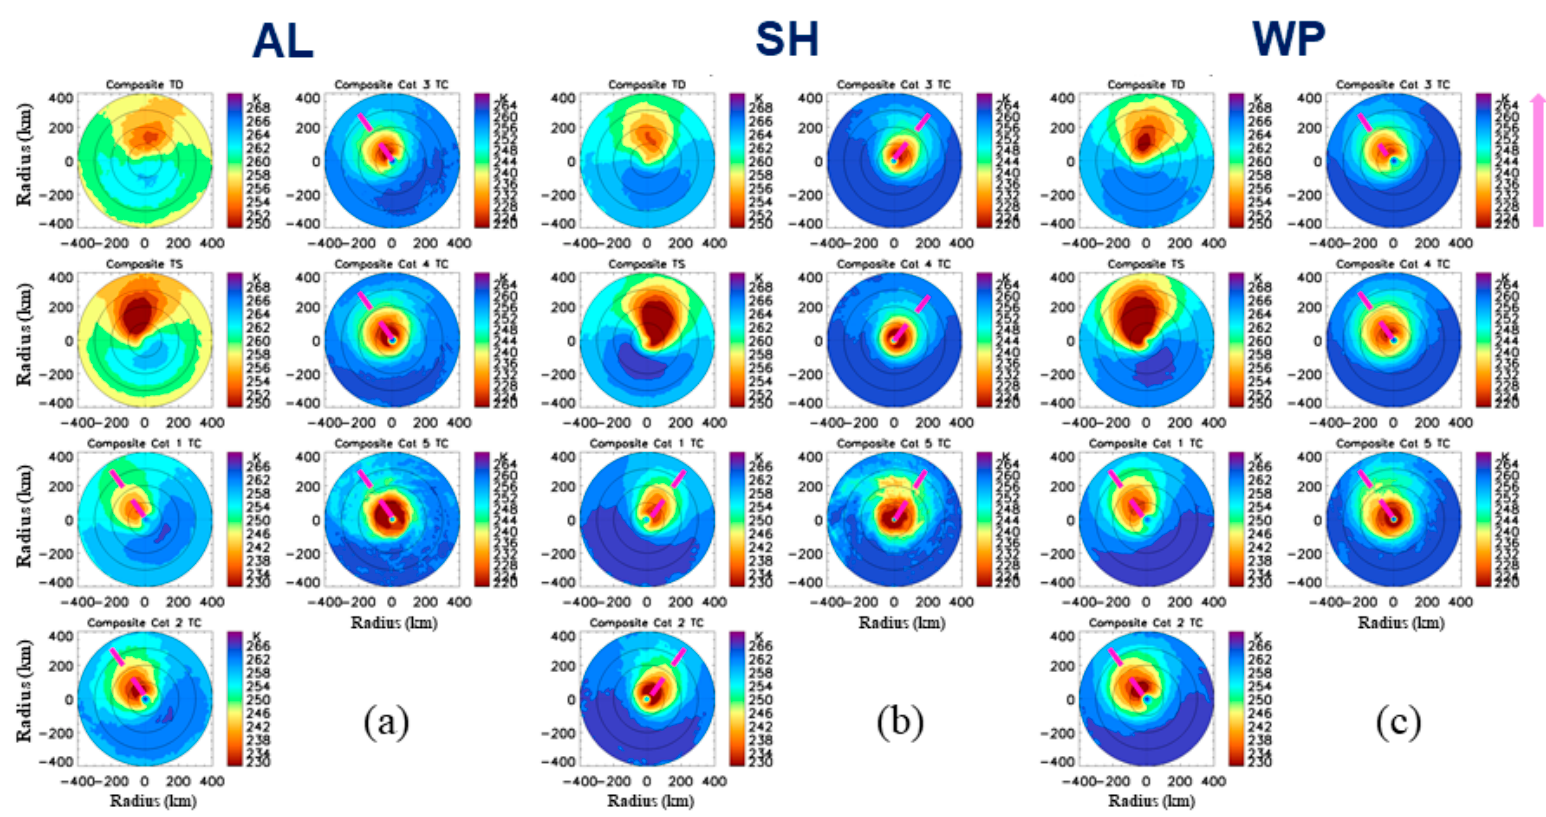
Figure 8. Same as Figure 7, except for relative to direction of the 200–850 hPa wind shear. The red dashed line is for axis of the minimum TBs.